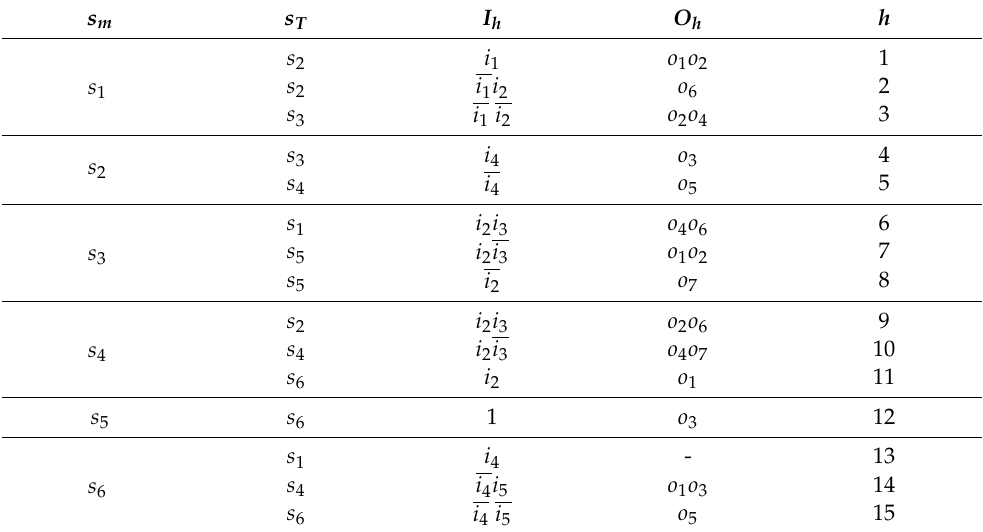
Table 1. STT of Mealy FSM A 0